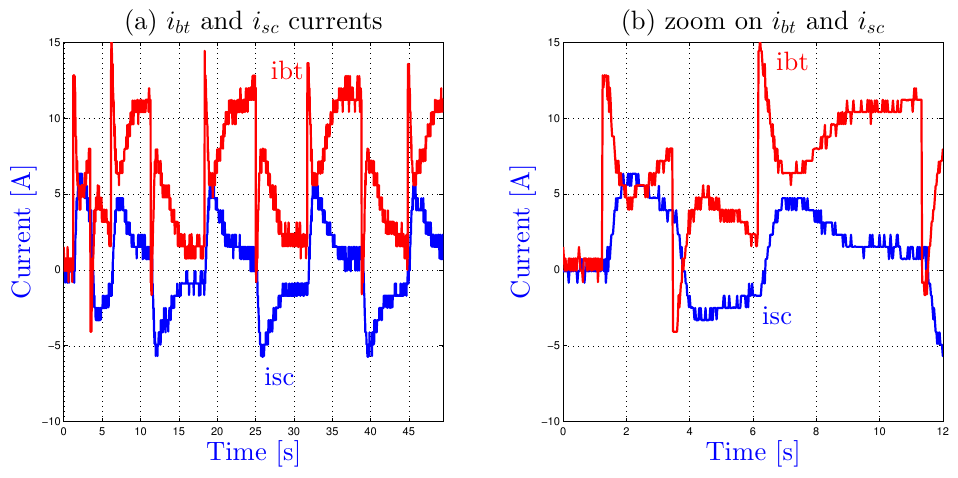
Figure 2. Experimental results with the regular controller—nominal condition.